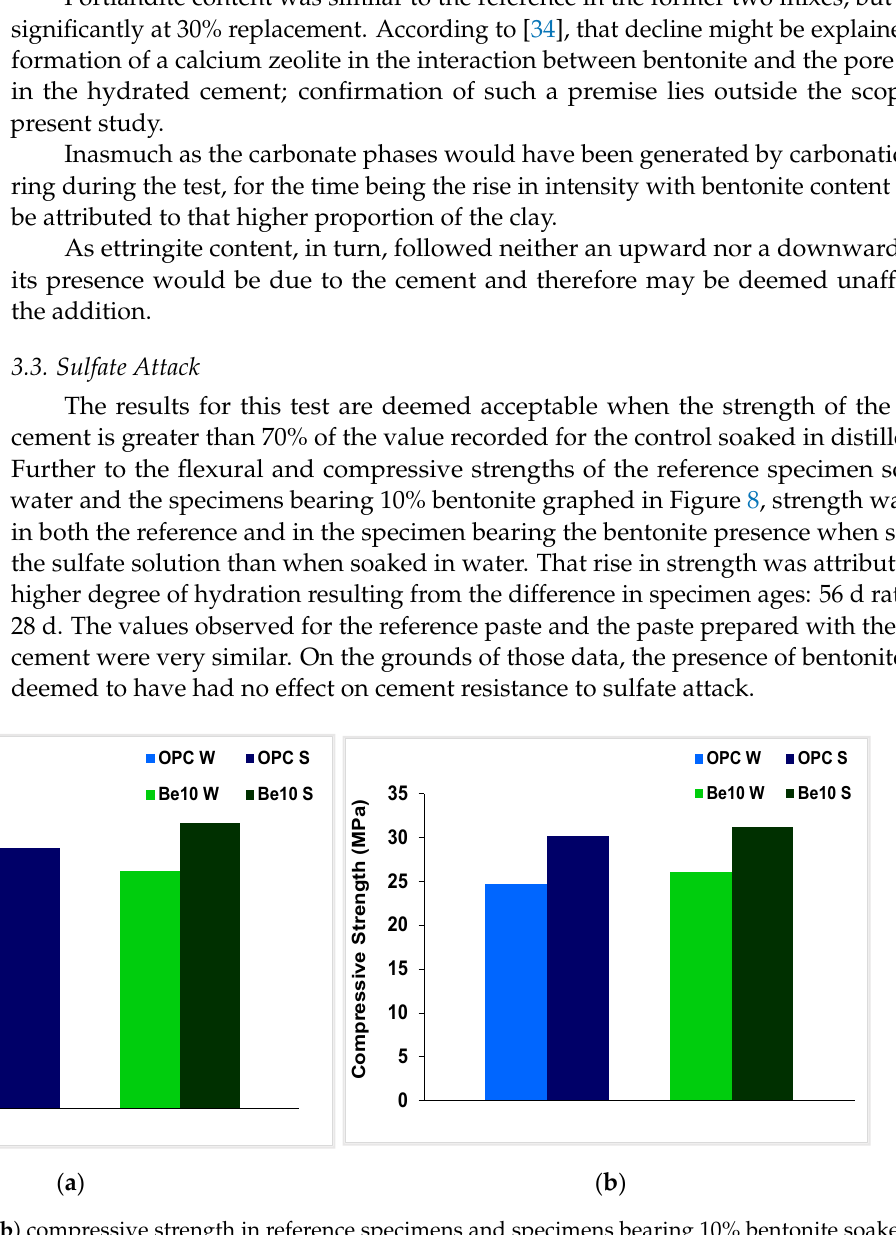
Figure 8. ( a ) Flexural and ( b ) compressive strength in reference specimens and specimens bearing 10% bentonite soaked in distilled water (W) or in sulfate (S).